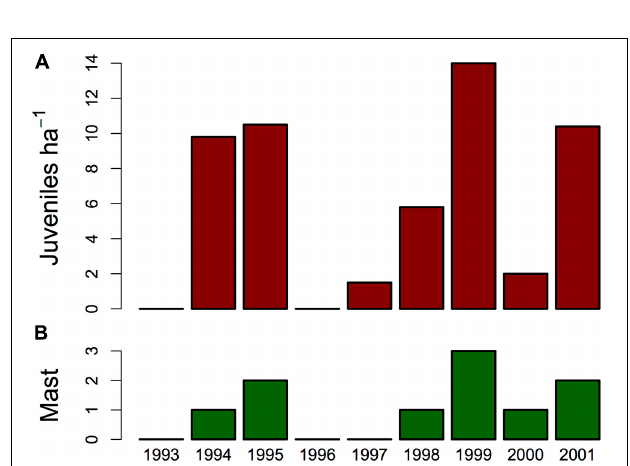
FIGURE 2 | (A) Year-to-year fluctuations in edible dormouse reproduction and density as determined by nest box controls over nine years at two study sites (data combined) in southwest Germany. Reproduction was low or even absent in 1993, 1996, 1997, and 2000. (B) This was correlated with a low or absent mast of beech trees. Bars represent the degree of beechnut production (codes 0–3 mean absence of beechnuts, some, good, and full mast, respectively). A rank correlation between this index and the number of juveniles detected per year was highly significant (Spearman’s rho 0.965, n = 9, P = 0.007). Based on data in Ruf et al. (2006).